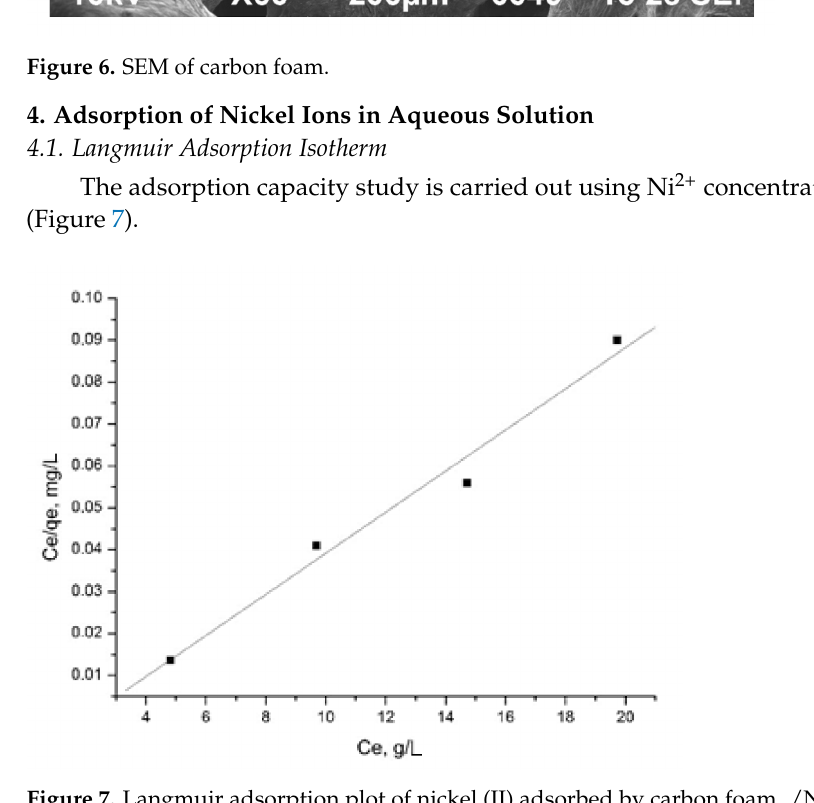
Figure 7. Langmuir adsorption plot of nickel (II) adsorbed by carbon foam. /Ni (II) concentration 10–40 mg/L; time 1 h; adsorbent concentration 0.1 g/50 mL/. Ni 2+ adsorption isotherm is well described by the Langmuir model [11]: C e /q e = C e /q m + 1/bq